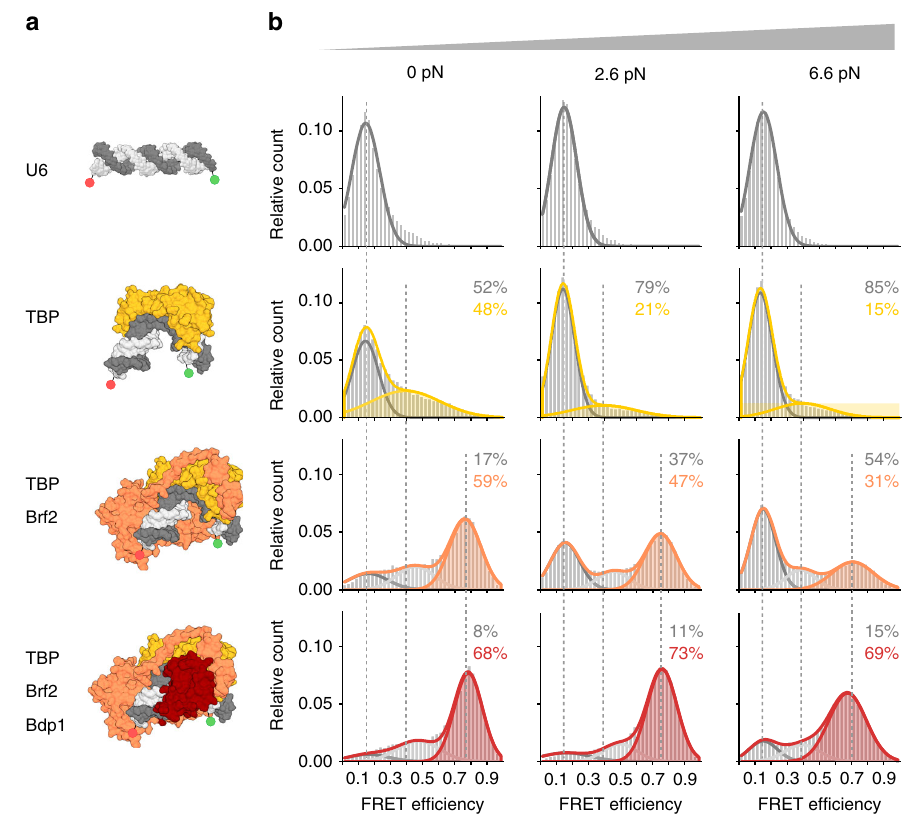
Fig. 3 Force dependency of promoter binding of RNAP III initiation factors at a canonical RNAP III promoter. a Structural model (PDB: 5N9G) of the U6 snRNA promoter (U6, dark grey) in an unbent conformation and the bent state bound by TBP (yellow), TBP/Brf2 (orange) and TBP/Brf2/Bdp1 (red). b Single-molecule FRET measurements on diffusing molecules monitor TBP-induced DNA bending after the addition of TBP (20 nM), TBP/Brf2 (20 nM) or TBP/Brf2/Bdp1 (20 nM) to the U6 DNA origami force clamps at increasing forces (0, 2.6 and 6.6 pN). FRET ef fi ciency histograms showing the relative distribution between the unbent DNA state (low FRET state, E = 0.19, grey) and TBP-induced bent states in the absence and presence of additional initiation factors (high FRET population, E = 0.39 (TBP only, yellow), E = 0.75 (TBP/Brf2, orange), E = 0.76 (TBP/Brf2/Bdp1, red)). Low and high FRET populations were fi tted with a Gaussian distribution. Each measurement was carried out at least three times. See also Supplementary Fig. 5